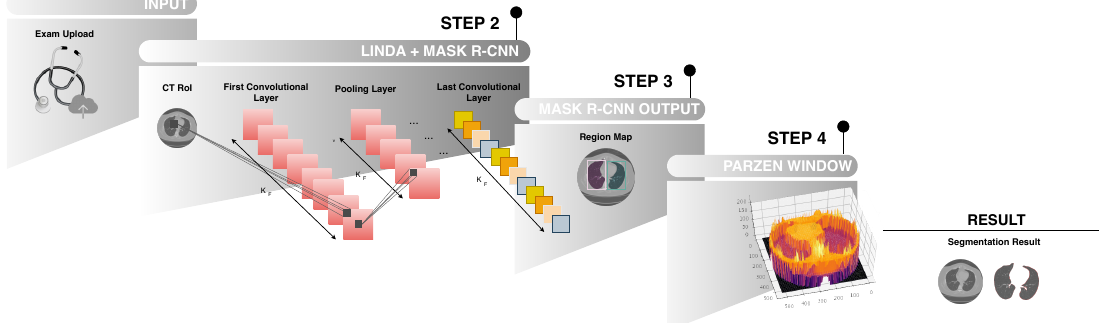
Figure 4. This Infogram represents the second phase of the proposed method. The image (INPUT), the result of the process of the first STEP 1 phase, is the input to the Mask R-CNN network. In ( STEP 2 ), the model based on deep learning creates a map of the proposed region belonging to the lung represented by the image ( STEP 3 –Mask R-CNN OUTPUT). And finally, Transfer Learning process using Parzen’s Window method in ( STEP 4 ) finishing with the segmentation of the lung